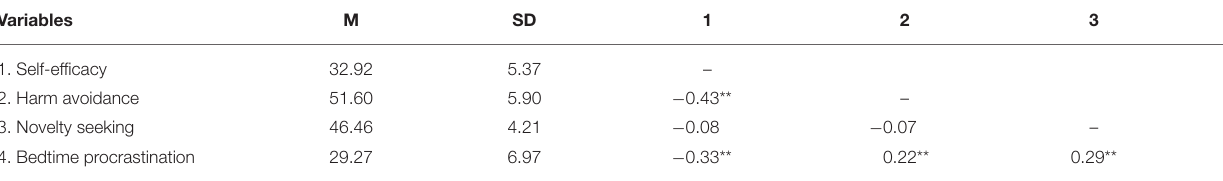
TABLE 1 | Descriptive statistics and correlations of study variables. Variables